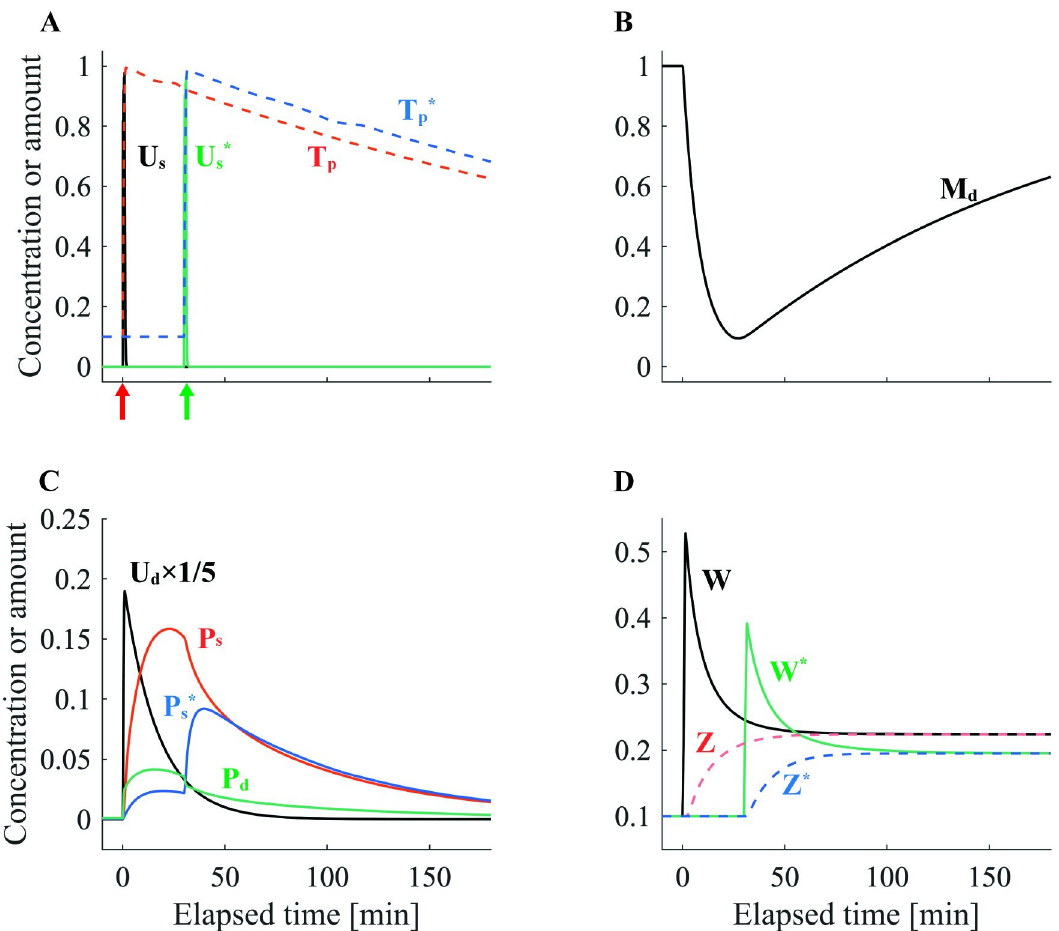
l-LTP–inducing stimulation protocol. The variables marked with asterisks are defined at the e-LTP–induced synapse.